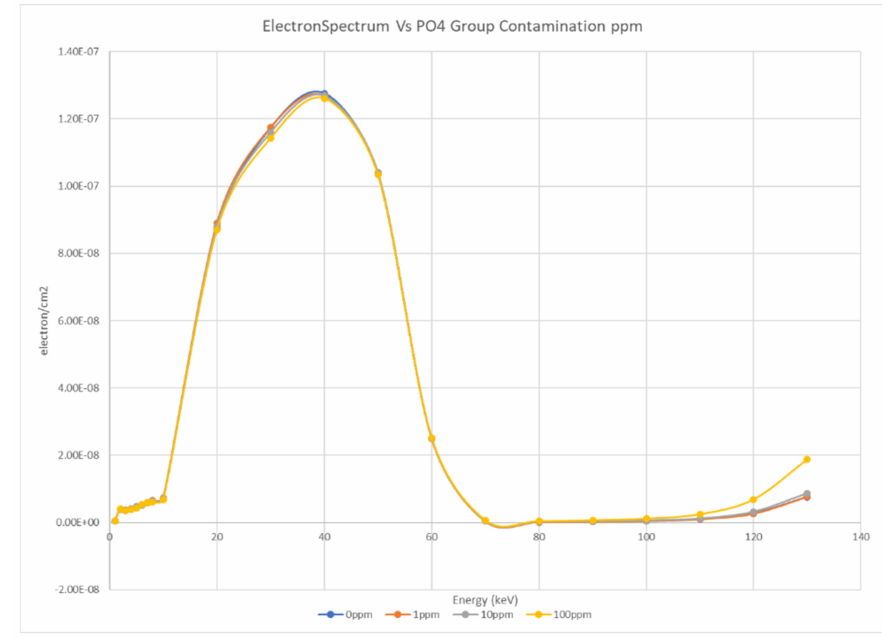
Figure 19. Electron spectrum—air sample vs.